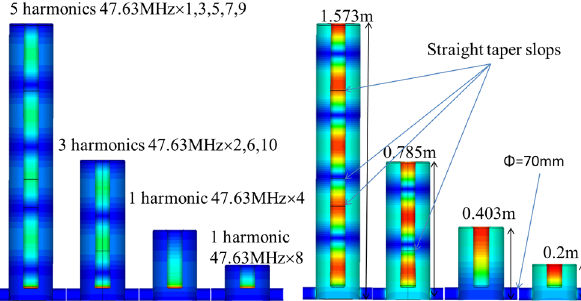
FIG. 12. 10 harmonic modes in a four-cavity system with the highest harmonic electric field (left) and magnetic field (right) distribution shown in each cavity.